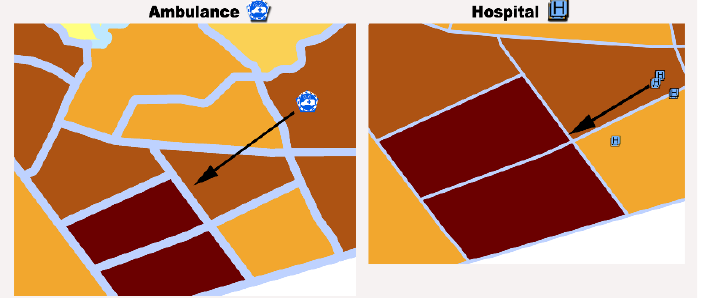
Figure 8. Map of the close neighbourhood.